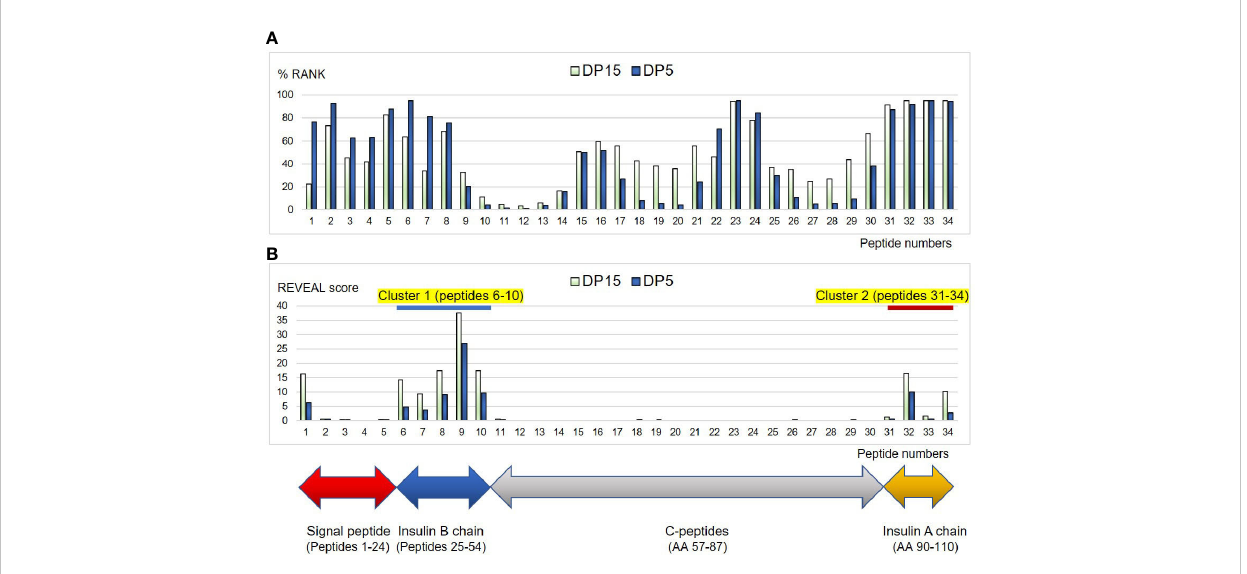
FIGURE 6 Binding af fi nities of the peptides derived from human proinsulin to HLA-DP5 (HLA- DPA1*02:02 , HLA- DPB1*05:01 ) or HLA-DP15 (HLA -DPA1*02:02 , HLA- DPB1*15:01 ) molecules are shown as %RANK in silico (A) , and shown as REVEAL score in vitro ( B ) . Horizontal numbers indicate peptide numbers used in the study (shown in Table 4). Note that lower %RANK means predicted strong binder in silico , and higher REVEAL score indicates peptide with high af fi nity in vitro . Cluster 1 (peptides 6-10) and Cluster 2 (peptide 31-34) were shown with blue and red line,